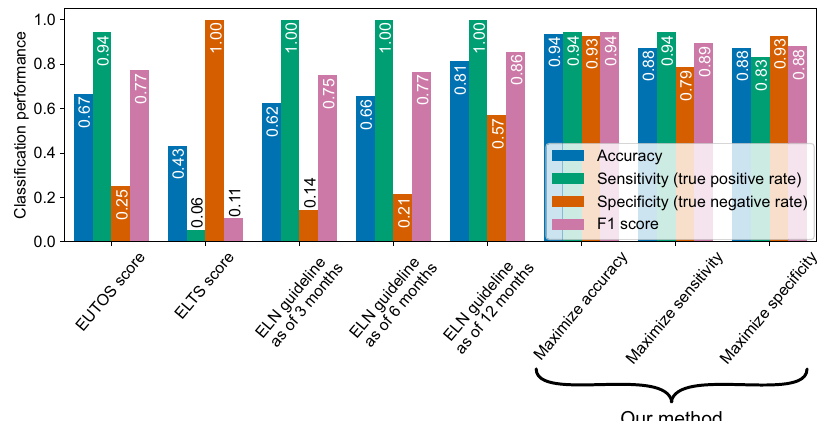
Fig. 4 Our prediction method achieved favorable performance in comparison with the criteria of the current scoring systems and guidelines. We summarize the performance for accuracy (blue bars), sensitivity (green bars), speci fi city (orange bars), and F1 scores (purple bars) of the EUTOS score, the ELTS score, the ELN guideline for the cases of 3, 6, 12 months, and our proposed method (presented with the three rightmost labels). In the current study, “ positive ” and “ negative ” indicate DMR and non-DMR patients, respectively. In the cases of the EUTOS scores, the ELTS scores, and the ELN guidelines, we decided to estimate a target patient as “ positive ” , if the patient was classi fi ed as “ Low risk ” or “ Optimal ” . Under this estimation, we obtained accuracy, sensitivity (the true positive rate), and speci fi city (the true negative rate) for each case. In our setting, the prediction of non-DMR patients is highly important, because the administrated TKI should be promptly changed for them. Thus, our method was superior to the EUTOS score and the ELN guideline because our method showed higher speci fi city than them. The ELTS score cannot distinguish between non-DMR and DMR patients. Notably, each of our three results was optimized in terms of accuracy, sensitivity, and speci fi city through the training period. See also “ DMR prediction criteria ” and “ Performance of DMR prediction ” in